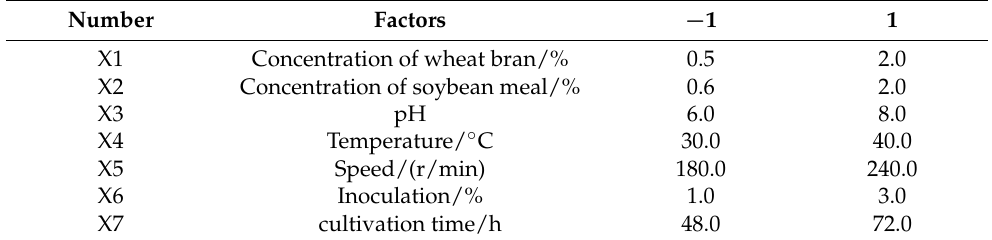
Table 1. Supplements for the screening of factors using Plackett–Burman method.